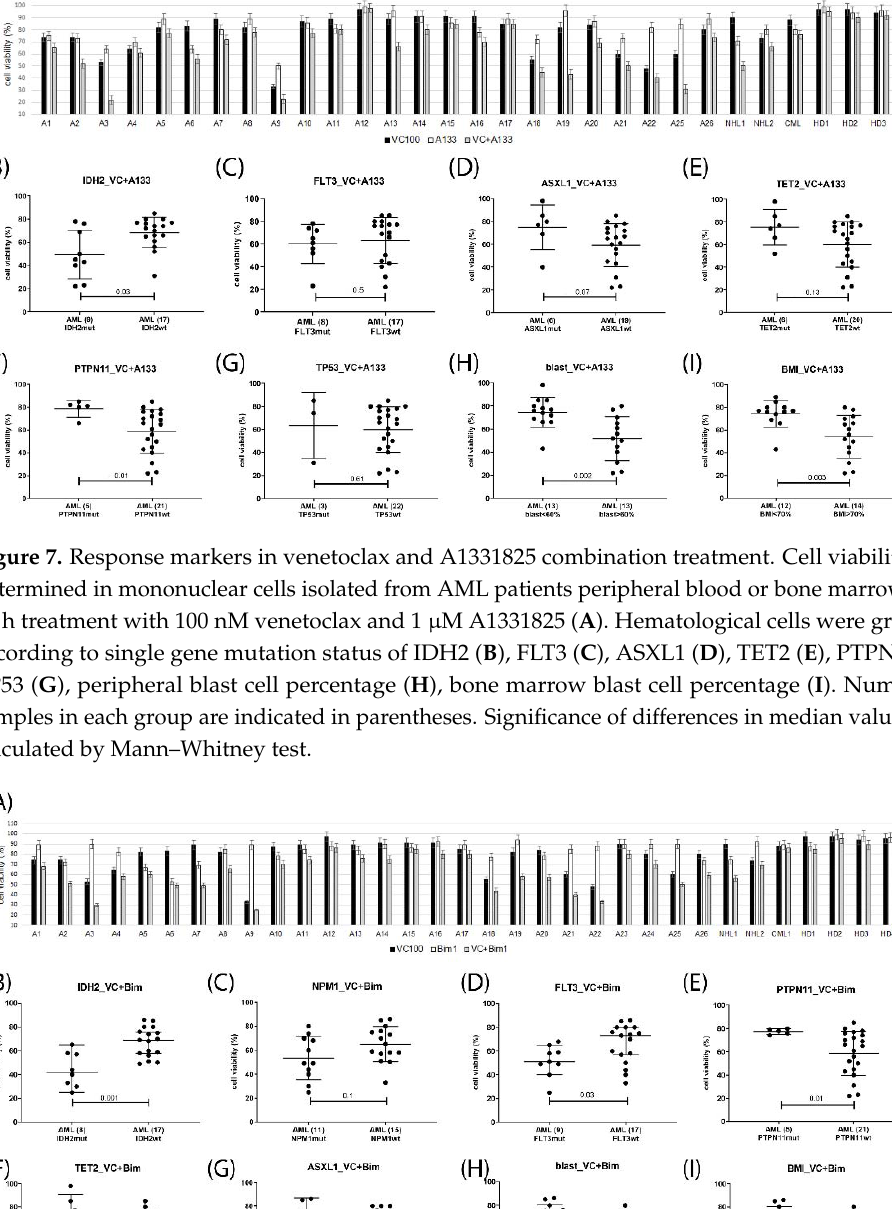
Figure 9. Response markers in venetoclax and S63845 combination treatment. Cell viability was de ‐ termined in mononuclear cells isolated from AML patients peripheral blood or bone marrow after 20 h treatment with 100 nM venetoclax and 100 nM S63845 ( A ). Hematological cells were grouped according to single gene mutation status of IDH2 ( B ), NPM1 ( C ), FLT3 ( D ), TET2 ( E ), PTPN11 ( F ), ASXL1 ( G ), peripheral blast cell percentage ( H ), and bone marrow blast cell percentage ( I ). Number of samples in each group are indicated in parentheses. Significance of differences in median values was calculated by Mann–Whitney test.